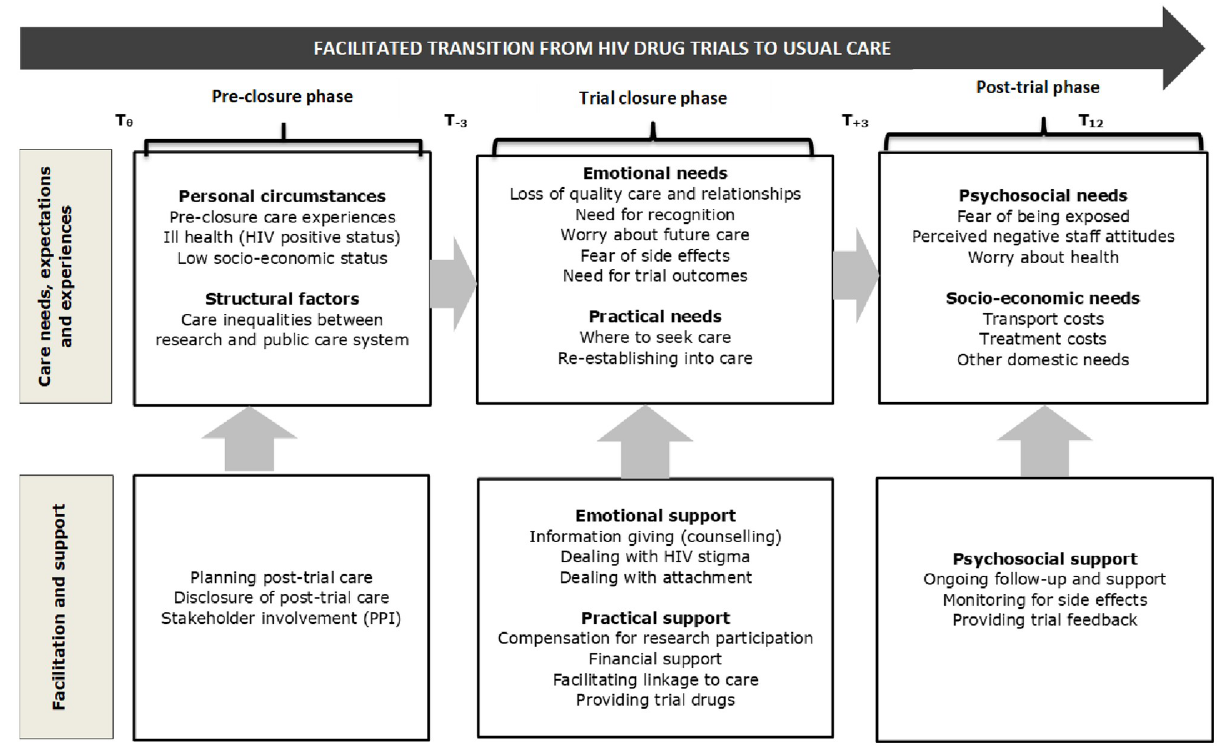
Fig 1. Model of facilitated